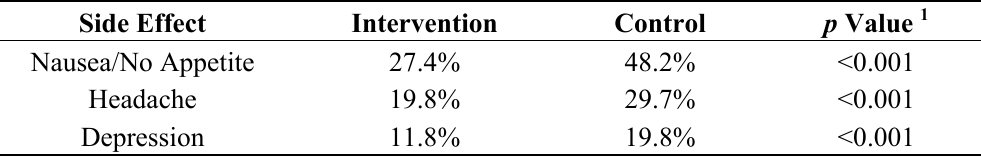
Table 5. Any complaint of specific side effect by